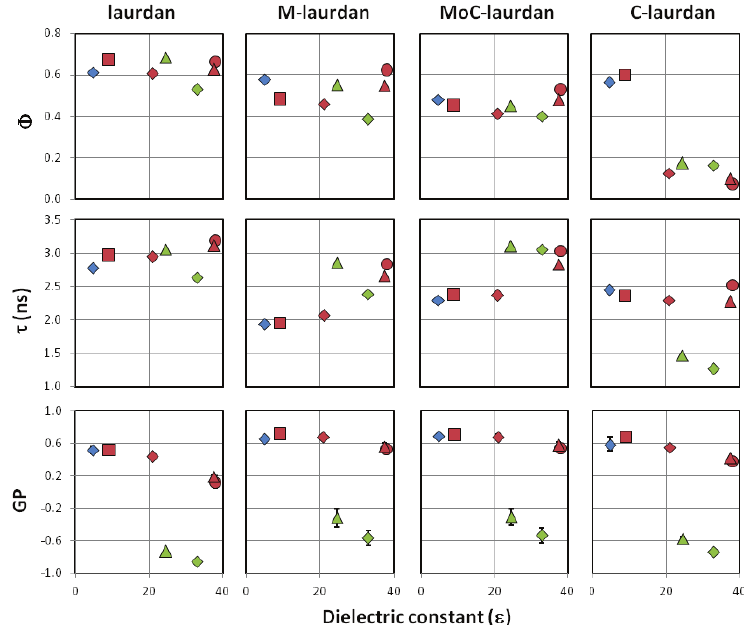
Figure 2. Spectroscopic properties (quantum yield, Φ ; lifetime, τ ; Generalized Polarization, GP) of laurdan, M-laurdan, MoC-laurdan and C-laurdan in various solvents. Blue, non-polar solvent ( ◆ chloroform), red, polar aprotic solvents ( ■ dichloromethane, ◆ acetone, ▲ acetonitrile, ● dimethylformamide), green, polar protic solvents ( ▲ ethanol, ◆ methanol). Experiments were performed twice and reported values are mean ± SD (not visible error bars are below the size of